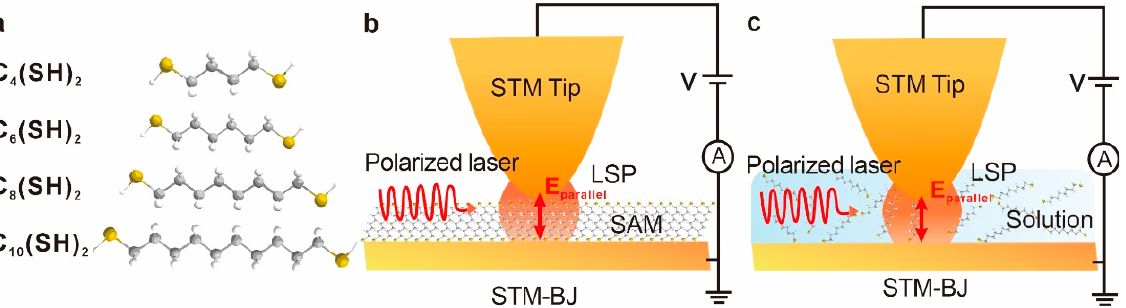
Figure 1. Schematics of STM-BJ measurements of probe molecules in SAM and solutions. ( a ) The chemical structures of four probe molecules are termed C 4 (SH) 2 , C 6 (SH) 2 , C 8 (SH) 2 , and C 10 (SH) 2 . ( b ) Schematic of STM-BJ measurements of probe molecules in SAM upon the illumination of polarized laser. The electric vector of polarized light is parallel to the electrode axis, denoted as E parallel . ( c ) Schematic of STM-BJ measurements of probe molecules in solution with 632 nm polarized laser.